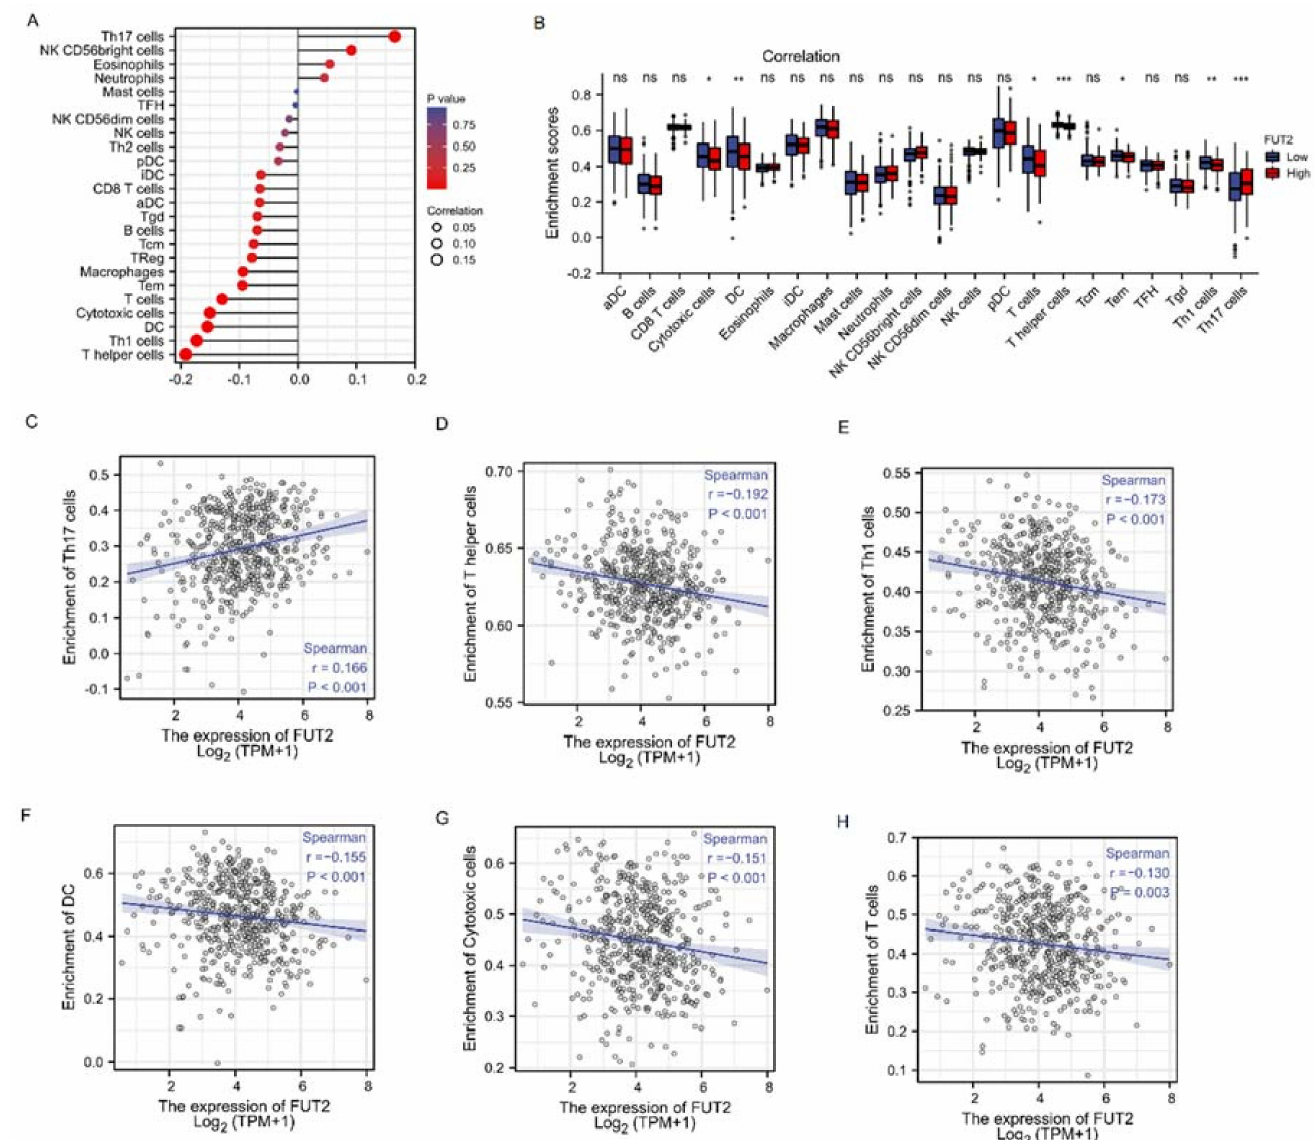
Figure 8. The association between FUT2 expression and immune infiltration in lung adenocarcinoma. ( A ) Correlation analysis between FUT2 and the 24 immune cell types. ( B ) Correlation analysis the different expression levels of FUT2 in 22 immunocyte types. ( C – H ) Pearson correlation analyses between FUT2 expression and the enrichment of immune cells, including Th17, T helper, Th1, DC, cytotoxic, and T cells. (ns: No significance, * p < 0.05, ** p < 0.01, and *** p <